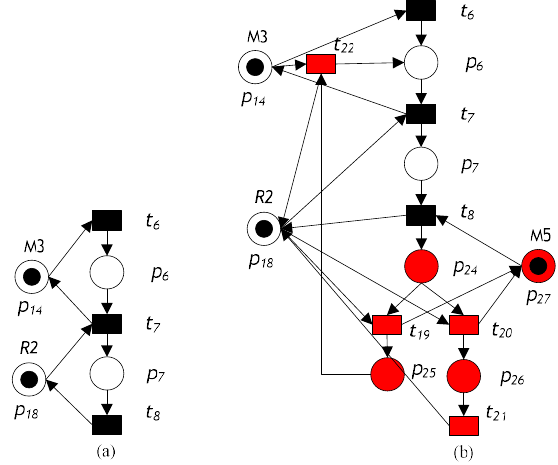
Figure 19. A reconfigured S 3 PR net by rework. ( a ) Left hand side net L . ( b ) Right hand side net R .